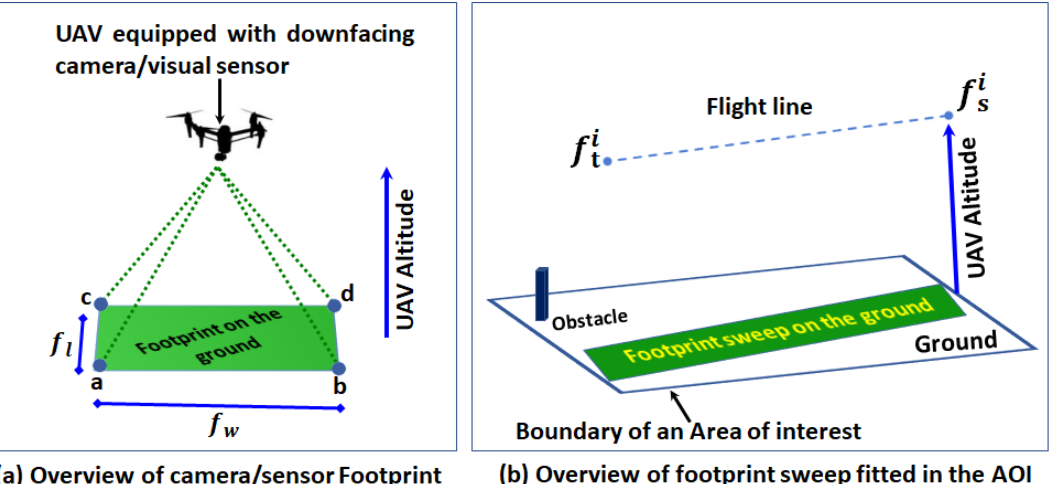
Figure 7. ( a ) Overview of the sensor footprint on the ground and ( b ) footprint sweep in the